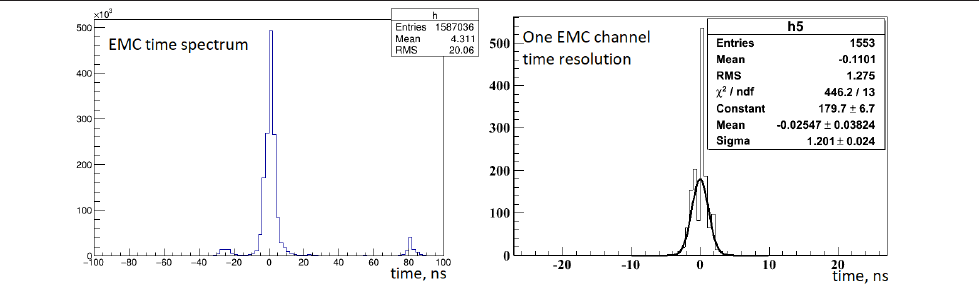
Figure 4. The linearization algorithm results on e + e − → e + e − events. On the left - the signal times for all triggered EMC counters with the main peak around zero as expected, due to the signal shape calibration procedure being performed on the same process. On the right - the obtained time resolution in one EMC counter on fitted signals with reconstructed energy deposition E > 100